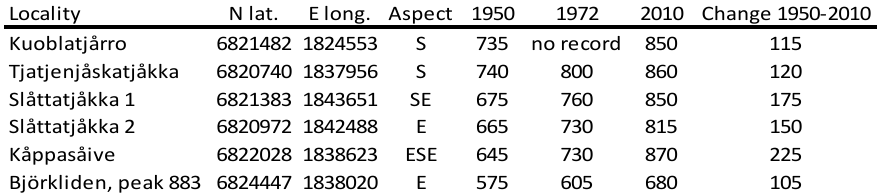
Table 2: Treeline positions (m a.s.l.) and elevational change (m) at six different localities in the Abisko area, as recorded in 1950, 1972 and 2010, respectively.